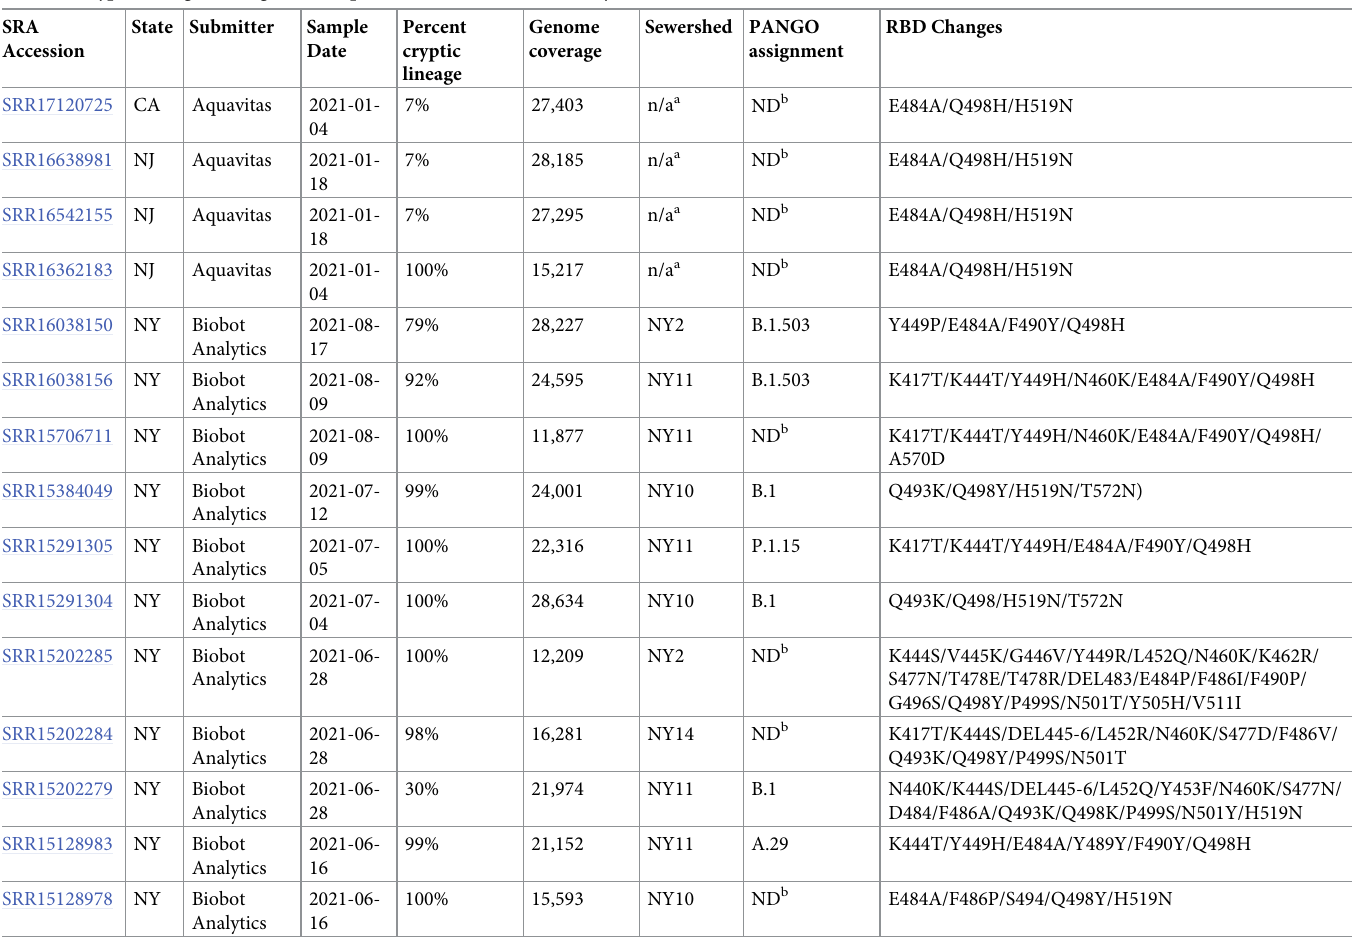
Table 2. Cryptic lineage whole genome sequences from nationwide